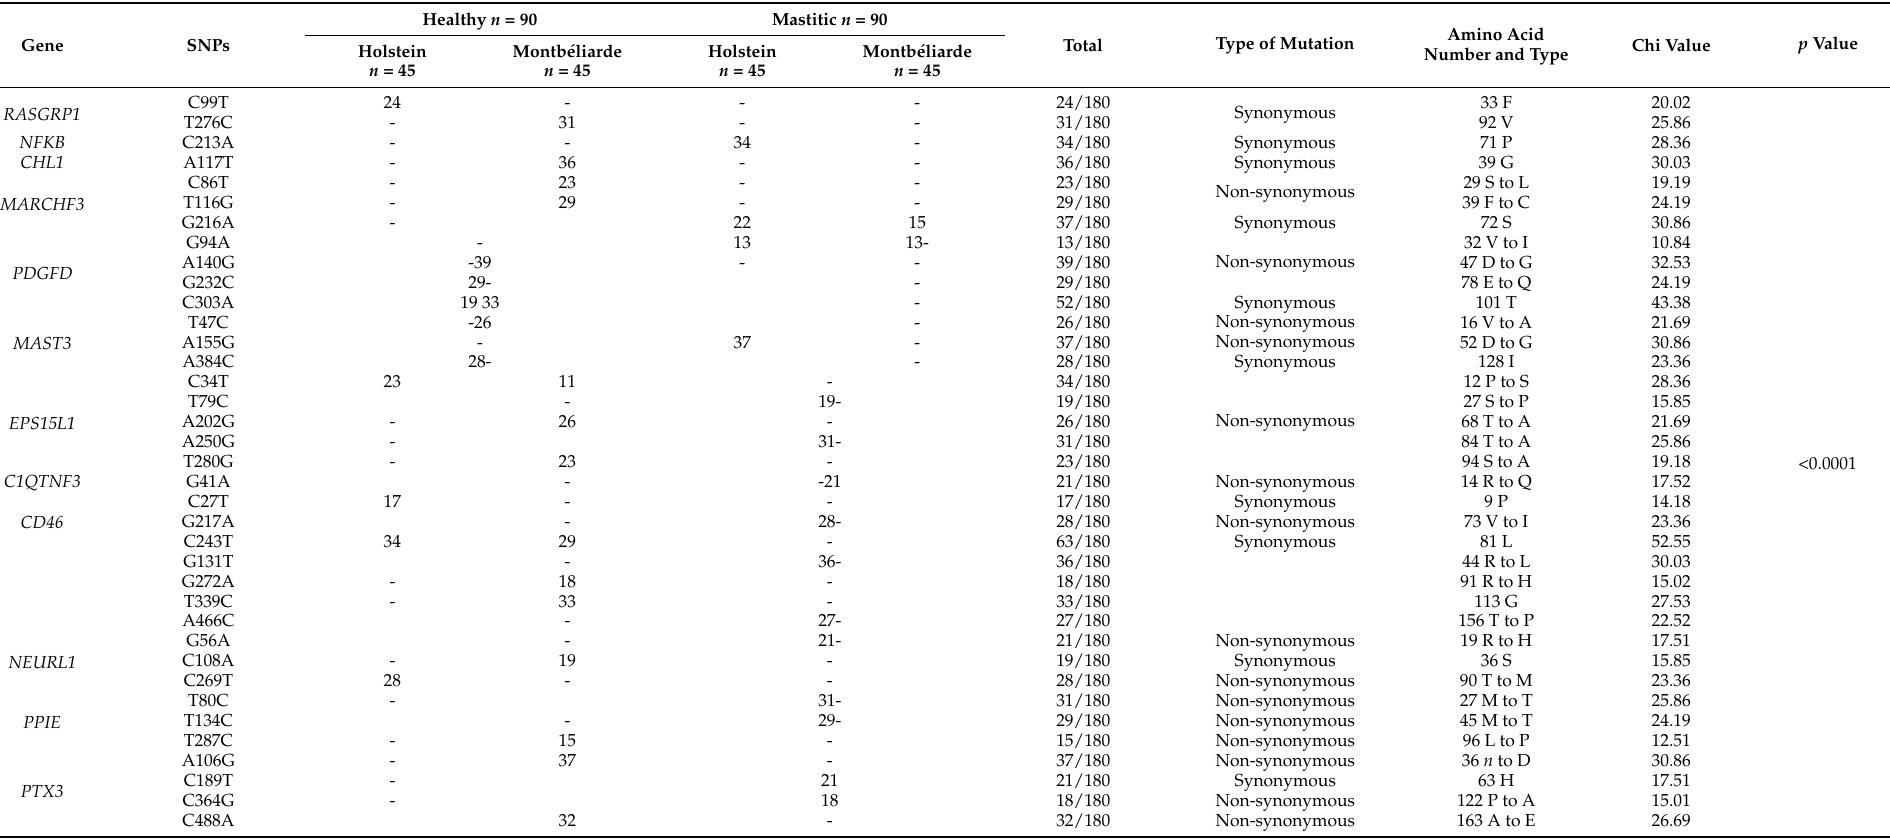
Table 3. SNP distribution and kind of mutation for the genes under investigation in in healthy and mastitic Holstein and Montb é liarde dairy